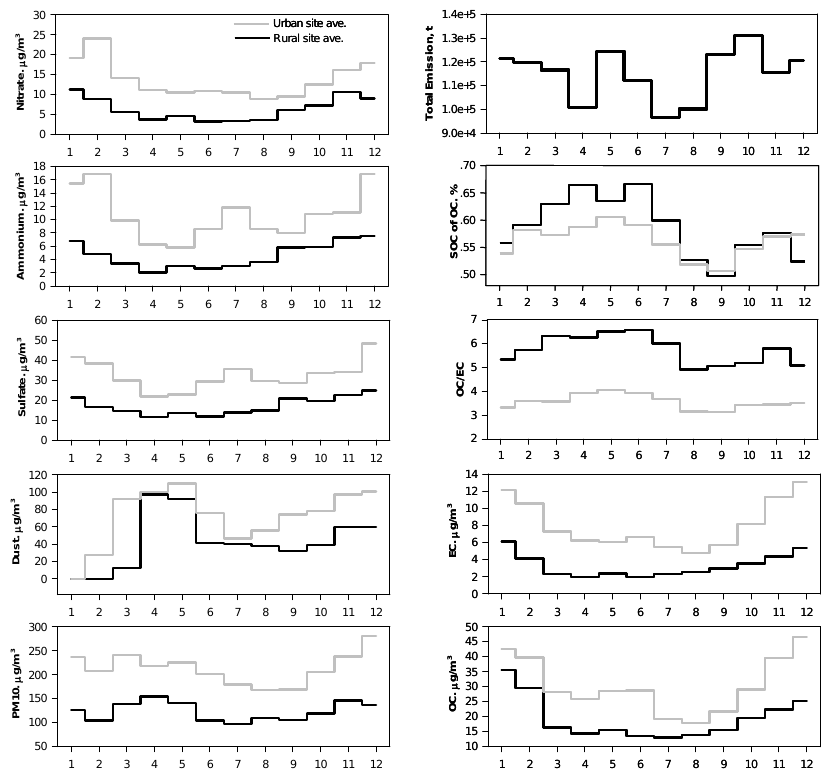
Fig. 6. Monthly changes of urban and rural mean concentrations of various aerosol species in China, also including the monthly variations of total aerosol and its precursor emission